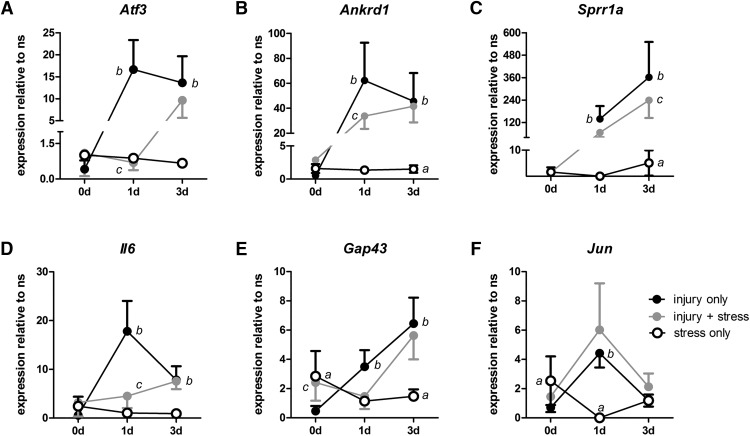
Stress represses injury-induced RAG expression. A-F, RAG expression in DRGs was evaluated by qRT-PCR from ns mice and compared to expression in DRGs isolated immediately (0) or 1 or 3 d after: stress only (open circles), injury only (black circles), or when restraint stress was applied 1 h before injury (gray circles). Stress alone increases Gap43 (E) and Jun (F) expression at 0 d, represses Jun at 1 d (F), and increases Ankrd1 (B), Sprr1a (C), and Gap43 (E) at 3 d. Stress compared to ns, ap < 0.05-0.0005. A-F, Injury significantly increases expression of all RAGs at 1 d and Atf3 (A), Ankrd1 (B), Sprr1a (C), IL6 (D), and Gap43 (E) at 3 d. Injury compared to ns mice, bp < 0.0001. A, B, D, Stress-reduced injury induction of Atf3 (A), Ankrd1 (G), and Il6 (I) at 1 d; Sprr1a (H) at 3 d; and increased Gap43 at 0 d. Injury compared to injury + stress, cp < 0.001-0.0001, one-way ANOVA with Bonferroni or Fisher’s post hoc tests. Mean ± SD are shown, N = 4 per group.